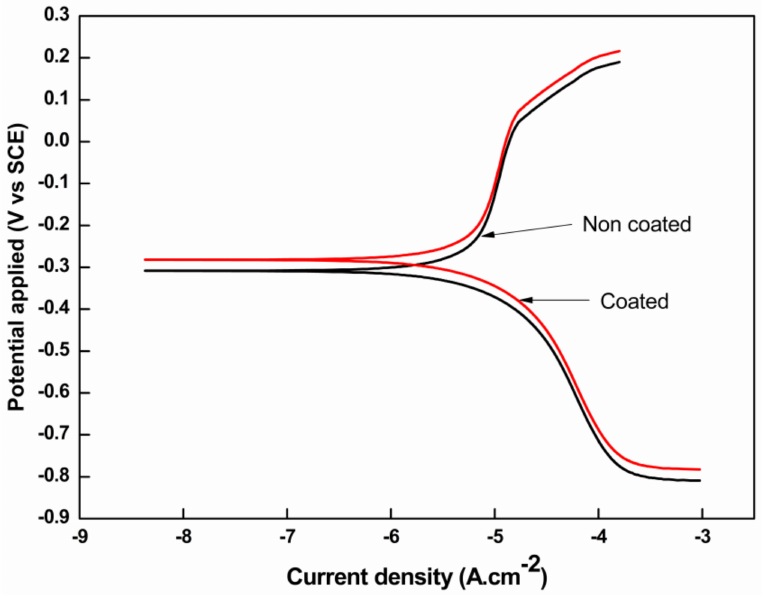
Figure 8. Potentiodynamic polarization curves of non-coated (control) and coated SS